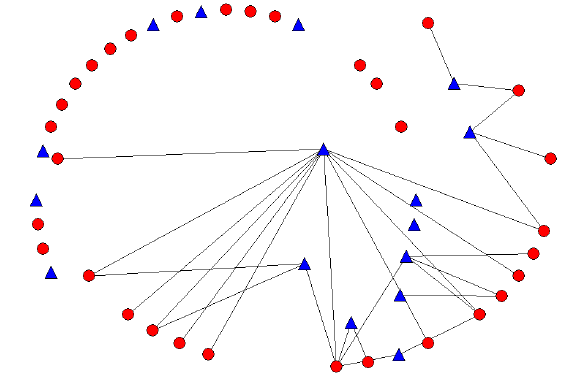
Figure 6: Knowledge network institutions-firms